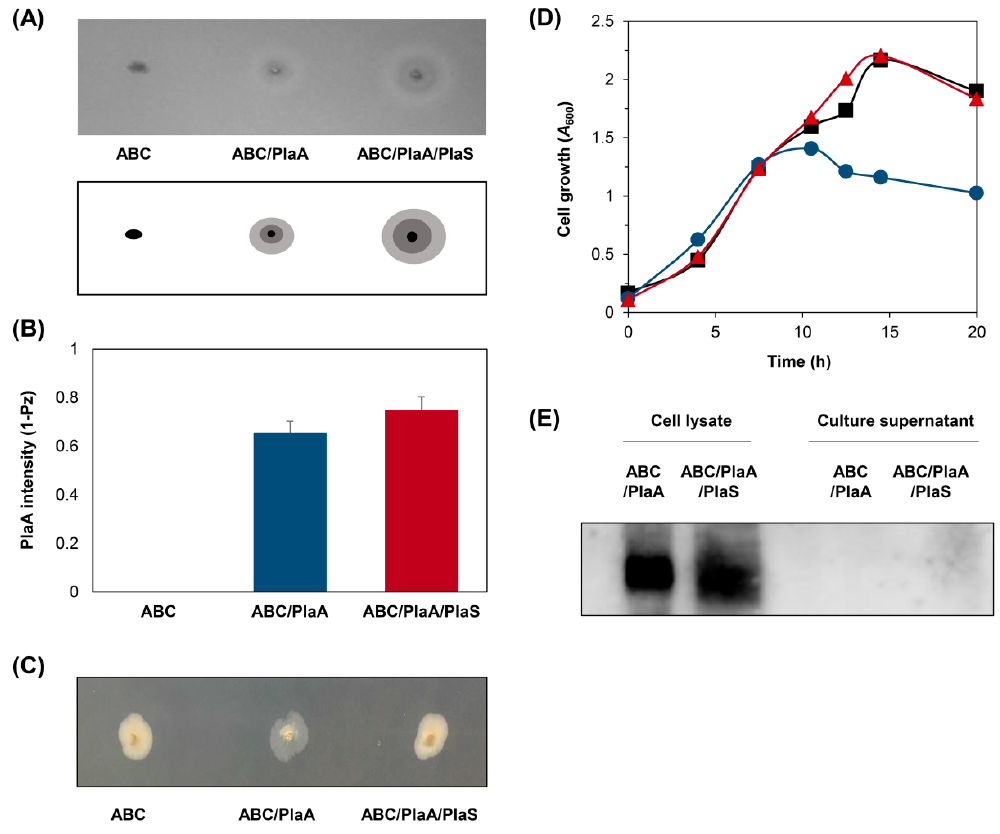
Figure 2. Phospholipase activity of recombinant PlaA in E. coli . ( A ) E. coli cells harboring each plasmid were grown on lecithin plates at 25 ◦ C for two days. The schematic diagram illustrates zones of colony (black), an opaque halo formed by fatty acid precipitation (dark grey), and a transparent halo formed by water-soluble lysophospholipid (light grey). ( B ) PlaA activity was quantified by measuring halo zones around colonies on the lecithin plate. The Pz refers to colony diameter divided by colony diameter plus opaque and transparent zones diameter so 1 – Pz = 0 means no activity. ( C ) E. coli cells harboring each plasmid were grown on LB agar plate at 37 ◦ C for four days. ( D ) Growth curves of E. coli harboring di ff erent plasmids, ABC ( (cid:4) ), ABC / PlaA ( • ), ABC / PlaA / PlaS ( (cid:78) ). The cells were cultured in the LB media with 1 mM IPTG added at A 600 = 0.8. ( E ) Western blot analysis of PlaA from the samples of cell lysates and culture supernatants. The plasmids shown in Figure 1A were used for comparison. Error bars represent the standard deviation from three independent